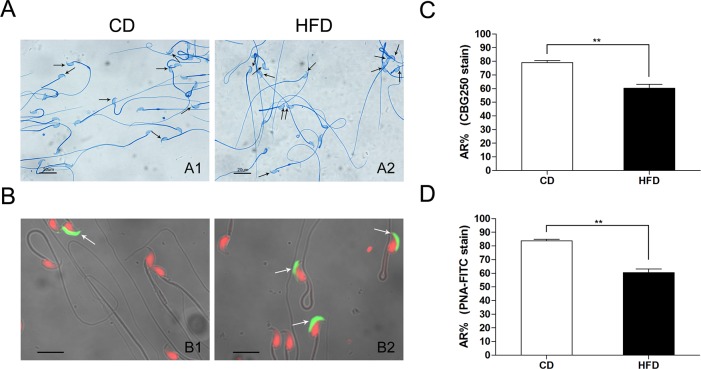
Effects of HFD on sperm acrosome reaction in mice.(A) Status of the mouse sperm acrosome stained with Commassie blue G250 in HFD and CD groups; the arrow indicates the intact acrosome stained with intensive blue. Scale bar = 20 μm. (B) Status of the mouse sperm acrosome stained with FITC-PNA, the arrow indicates the intact acrosome exhibiting green fluorescence. The red fluorescence indicates sperm nuclei stained with Propidium Iodide. Scale bar = 10 μm. A1 and B1: spermatozoa from CD mice; A2 and B2: spermatozoa from HFD mice. AR: acrosome reaction; CBG250: Commassie blue G250. Data are expressed as mean ± SEM. **P<0.01.